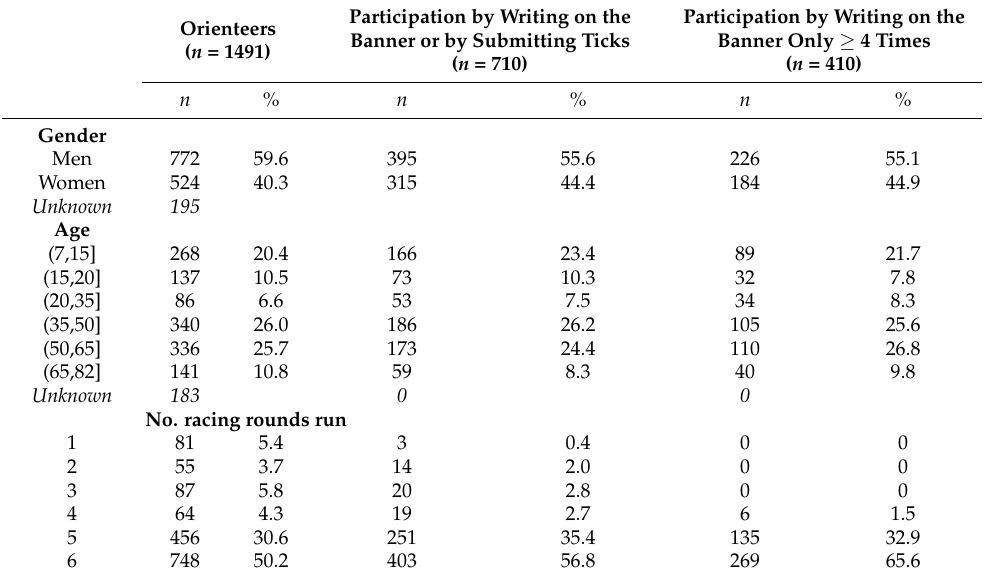
Figure 3. Participation rates in the study per racing round : proportion of orienteers participating in the study per racing round by reporting tick information on the banner and/or by submitting ticks (in yellow) and the proportion of orienteers who reported tick information on the banner considering only those that reported tick information on the banner at least four times (i.e., the restricted banner dataset, in blue). The number in parentheses represents the number of orienteers participating in the competition. * Racing round 1: no ticks were collected. Table 1. Characteristics of the whole population of orienteers and of the population of study (i.e., the orienteers who reported tick information on the banner and/or submitted ticks) related to gen ‐ der, age, and racing round number.